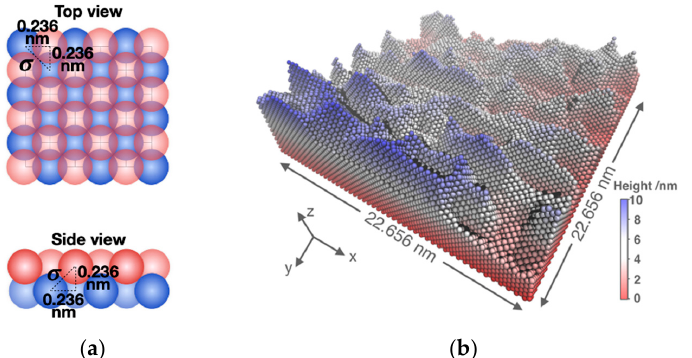
Figure 2. Construction of the surface model with natural Ketton topography. ( a ) Illustrates how the beads are arranged into a surface with a face-centered cubic (FCC) structure over a 6 × 6 grid. The top image shows the arrangement viewing from the top of the surface, and a side view of the unit cell is placed below. The diameter of all beads is 0.33 nm. ( b ) Model surface constructed over the 96 × 96 selected grids; the elevation at each grid point is based on AFM measurements, given in Figure 1c. The color of the beads indicates their elevations in the z -direction.